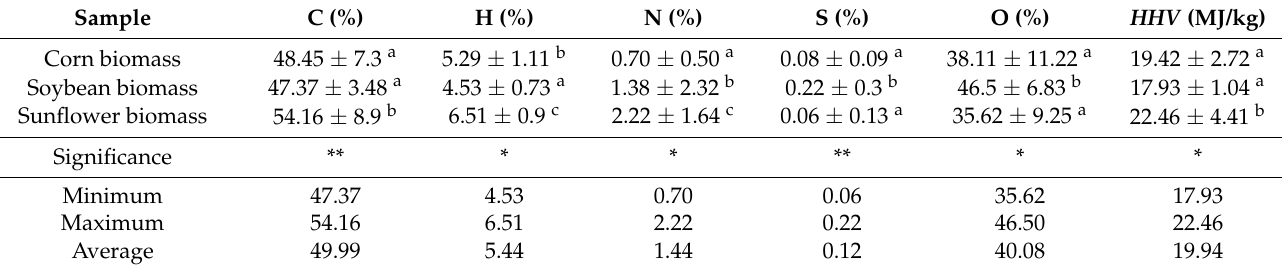
Table 1. Ultimate analysis of corn, soybean and sunflower biomass.